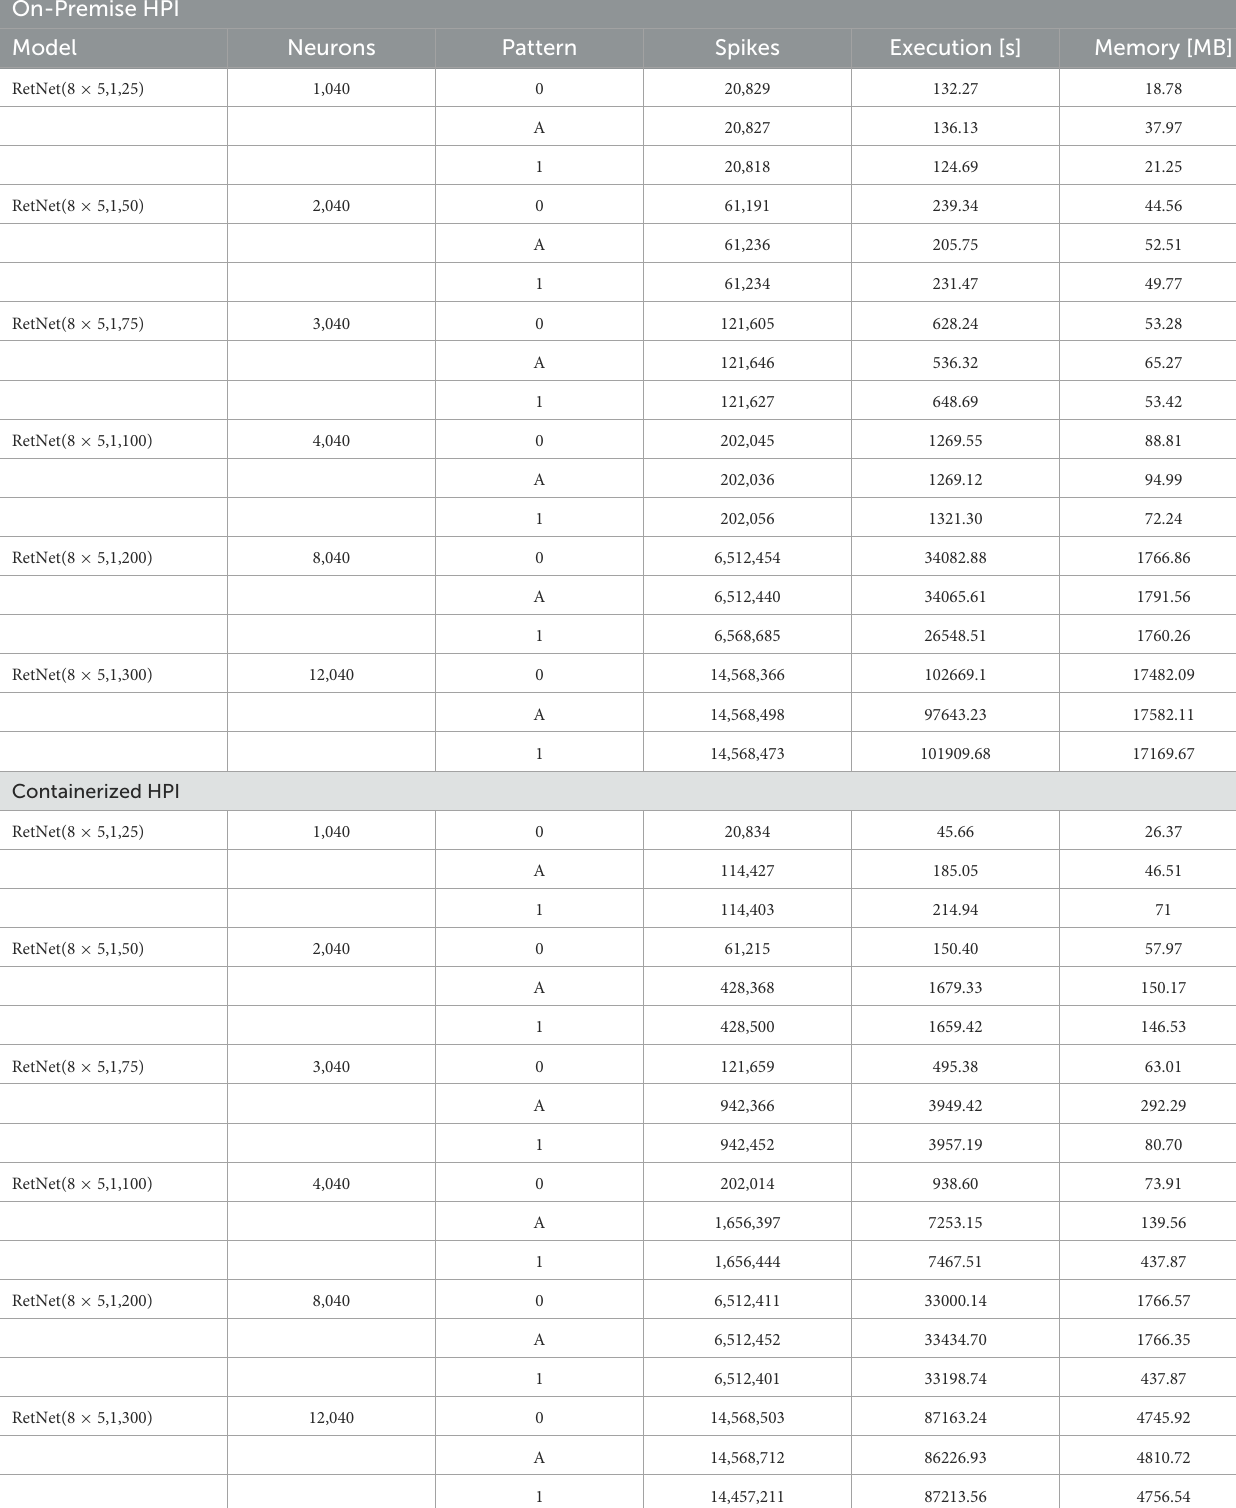
TABLE 2 Neural Simulation Pipeline—standard vs. containerized execution on HPI infrastructure. On-Premise